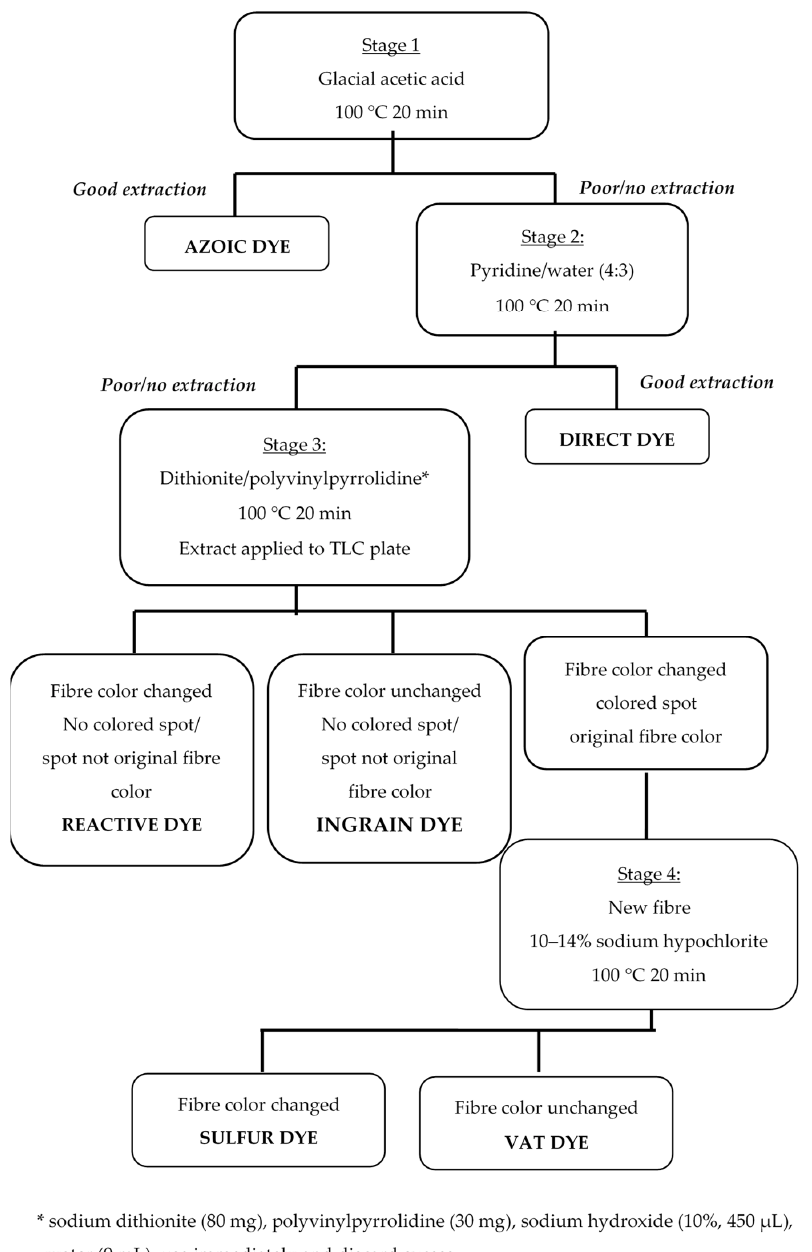
Figure 8. Classification scheme for the extraction of dyes from cotton and viscose fibers. Reprinted